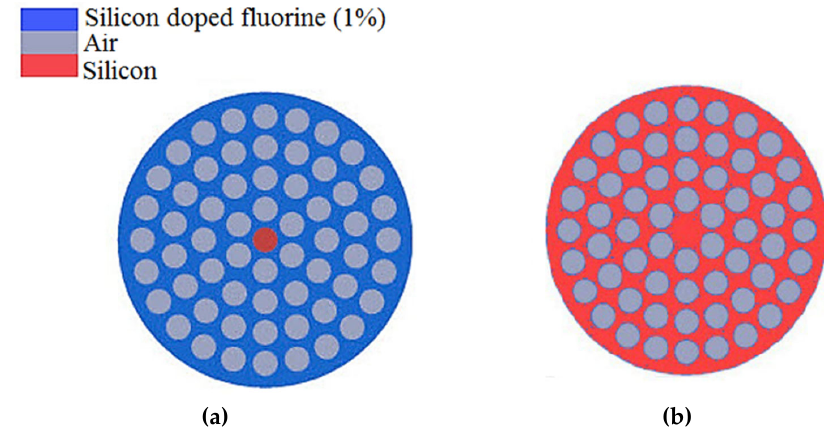
Figure 1. The schematics of the proposed PCFs with ( a ) silicon core and fluorine (1%) doped silica cladding, ( b ) entirely silicon background.